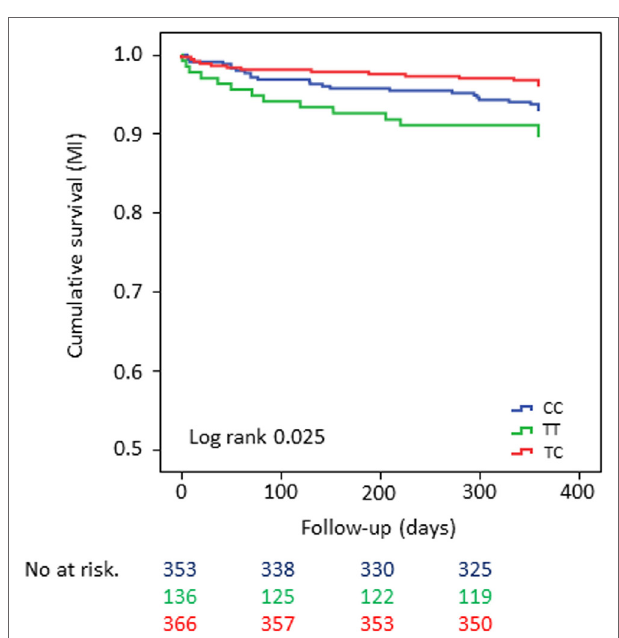
FigUre 2 | Kaplan–Meier curves showing cumulative survival [myocardial infarction (MI)] stratified according to GP la rs1126643 homozygous carriers of major allele, heterozygous and homozygous carriers of minor allele. No. at risk: blue = homozygous carriers of major allele, green = homozygous carriers of minor allele, red = heterozygous carriers of minor